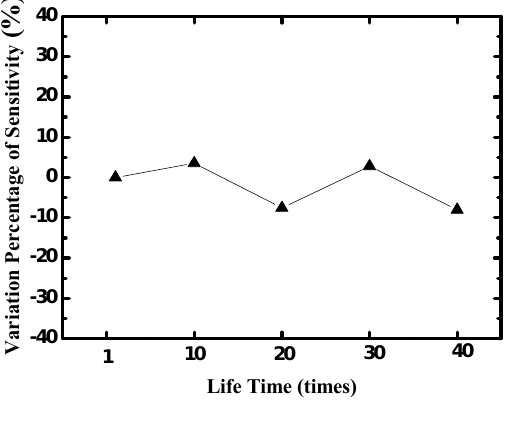
Figure 10. The life time of the glucose biosensors on TNTs